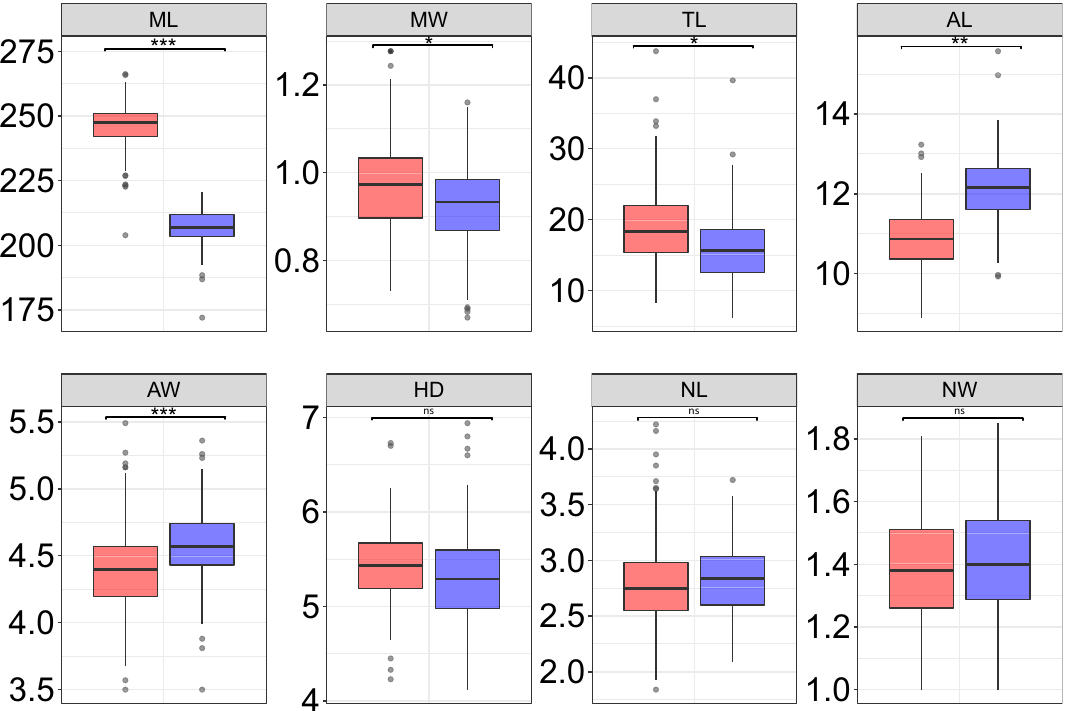
Figure 3. Differences in the sperm traits between the common nightingale (red) and thrush nightingale (blue) using confocal microscopy data. Following traits were compared: midpiece length (ML), midpiece width (MW), tail length (TL), acrosome length (AL), acrosome width (AW), helix distance (HD), nucleus length (NL) and nucleus width (NW). All measurements are shown in µm. Medians, quartiles, 1.5 quartile range and outliers (based on 200 measured sperm per each species) are shown. P-value: ns = P > 0.05; * = P ≤ 0.05; ** = P ≤ 0.01; *** = P ≤